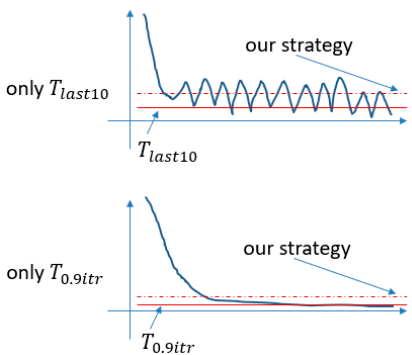
Figure 14. Schematic diagrams to explain the problems when only one threshold is used.